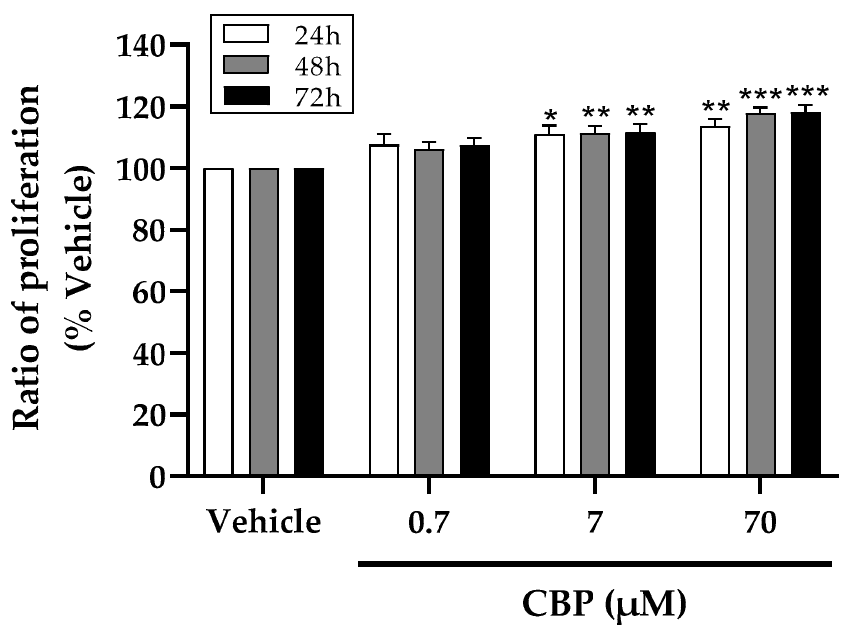
Figure 1. Effects of CBP on cell proliferation. CBP at concentrations of 0.7, 7, and 70 µ M was tested for inducing cell proliferation at 24, 48, and 72 h. MTT assays were performed by measuring absorbance at 570 nm. n = 5. Data are presented as means ± SEMs and analyzed by one-way ANOVA followed by Tukey’s multiple comparison test. * p < 0.05, ** p < 0.01, and *** p < 0.001 vs. vehicle.